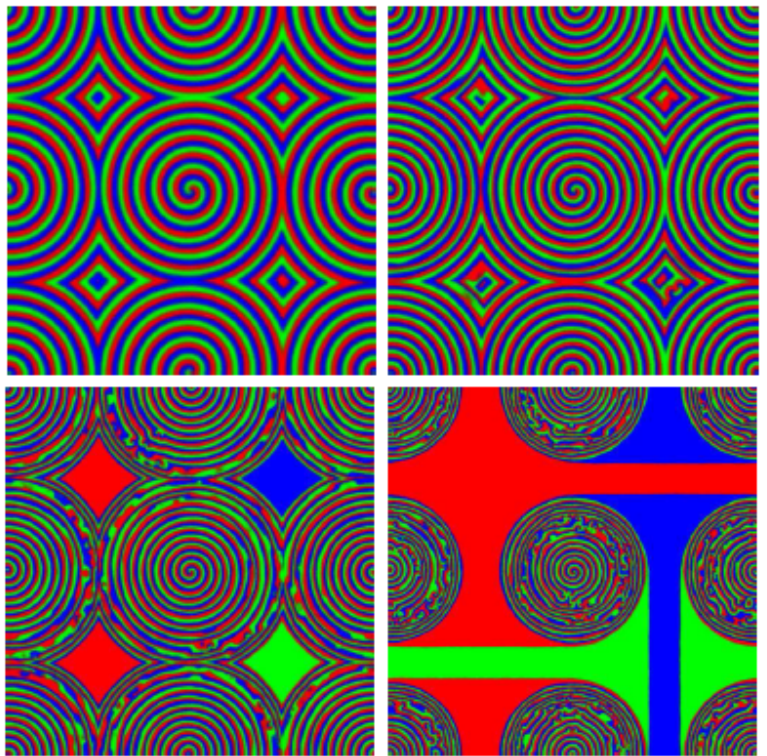
Figure 5. (Color online). Typical snapshots of stochastic lattice simulations of the model with ( β , σ , ζ , µ ) = ( 1,1,0,0 ) , N = 256 and L = 512 and different mobility after a time t = 800. In each panel, the initial condition (geometrically ordered and partially visible in the bottom right panel) is the same. The mobility rate is from left to right: δ = 0.4 and δ = 0.2 in the top row, and δ = 0.1 and δ = 0.05 in the bottom row. Adapted from